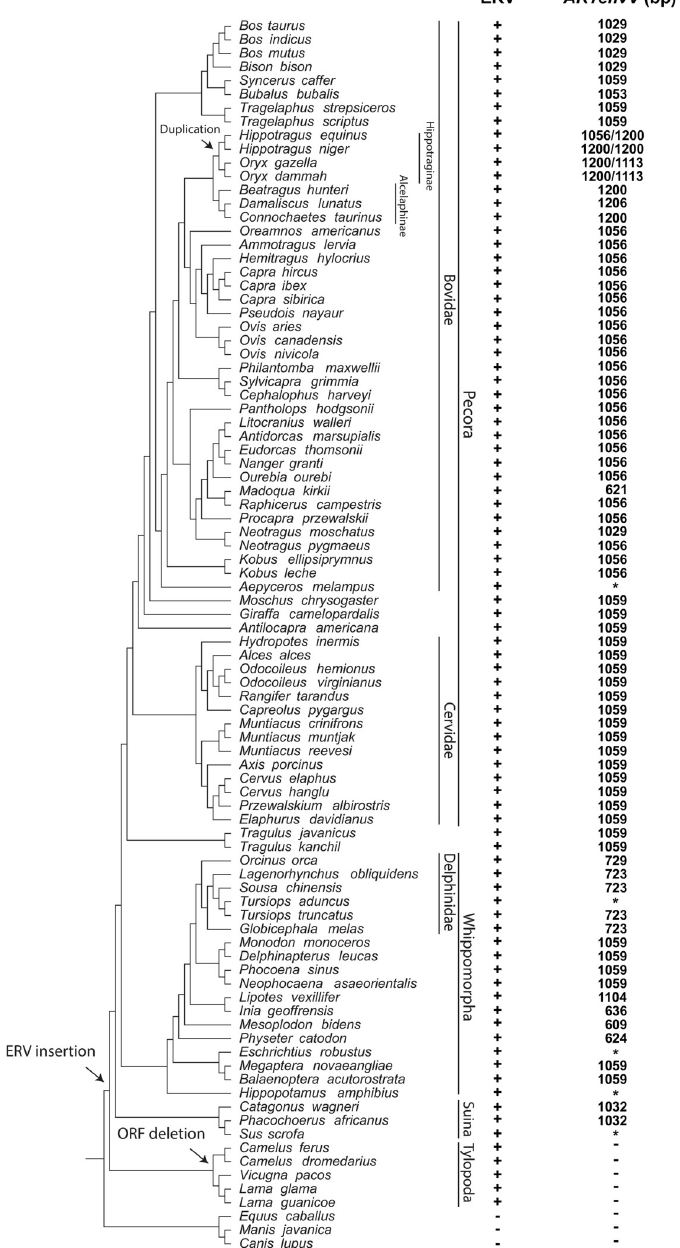
Fig 4. Conservation of ARTenvV ORF in the lineages of Artiodactyla. Shown is a cladogram illustrating the evolutionary relationships for species with assembled genomes in the order Artiodactyla along with three species from sister orders of Artiodactyla. Suborder, family and subfamily classifications are shown on the right. The species tree was generated with TimeTree [82]. + indicates the presence and–indicates the absence of ERV orthologs that contain ARTenvV as identified via BLAST searches of each genome assembly. The size of the ARTenvV ORF found in the orthologous location at each genome assembly is indicated. � indicates a very early stop codon caused by an insertion or deletion. Arrows mark the insertion and fixation of the ERV that encodes ARTenvV , retroduplication of ARTenvV , and the deletion of the ARTenvV ORF. and CARenvV (S2 Fig). To determine whether these ERVs are in a location of conserved syn- teny, we aligned the genomic region surrounding each ERV from 15 species of Artiodactyla or